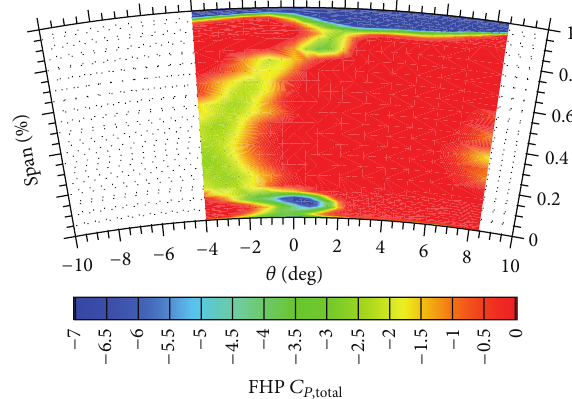
Figure 17: FHP coefficient of total pressure,